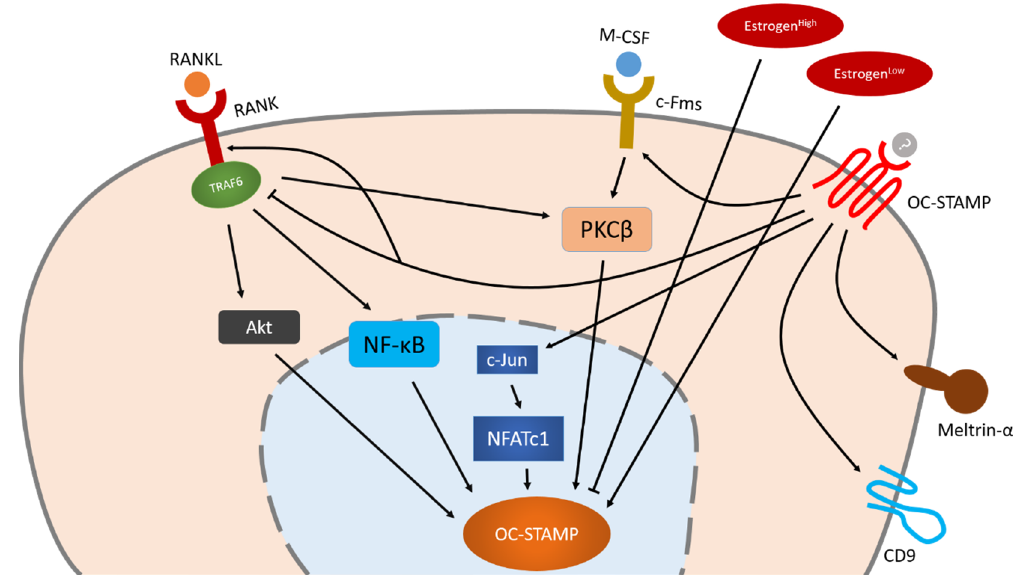
Figure 2. Schematic illustration of OC-STAMP regulation during osteoclastogenesis. NFATc1 is the master transcription factor of OC-STAMP, but Akt, NF- κ B and PKC β also play an important role in OC-STAMP’s regulation which is independent of NFATc1. OC-STAMP-induced signaling may positively influence other fusogens such as CD9 and meltrin- α , enabling them to regulate osteoclast multinucleation together. Arrow indicate positive regulation, bars indicate negative regulation.